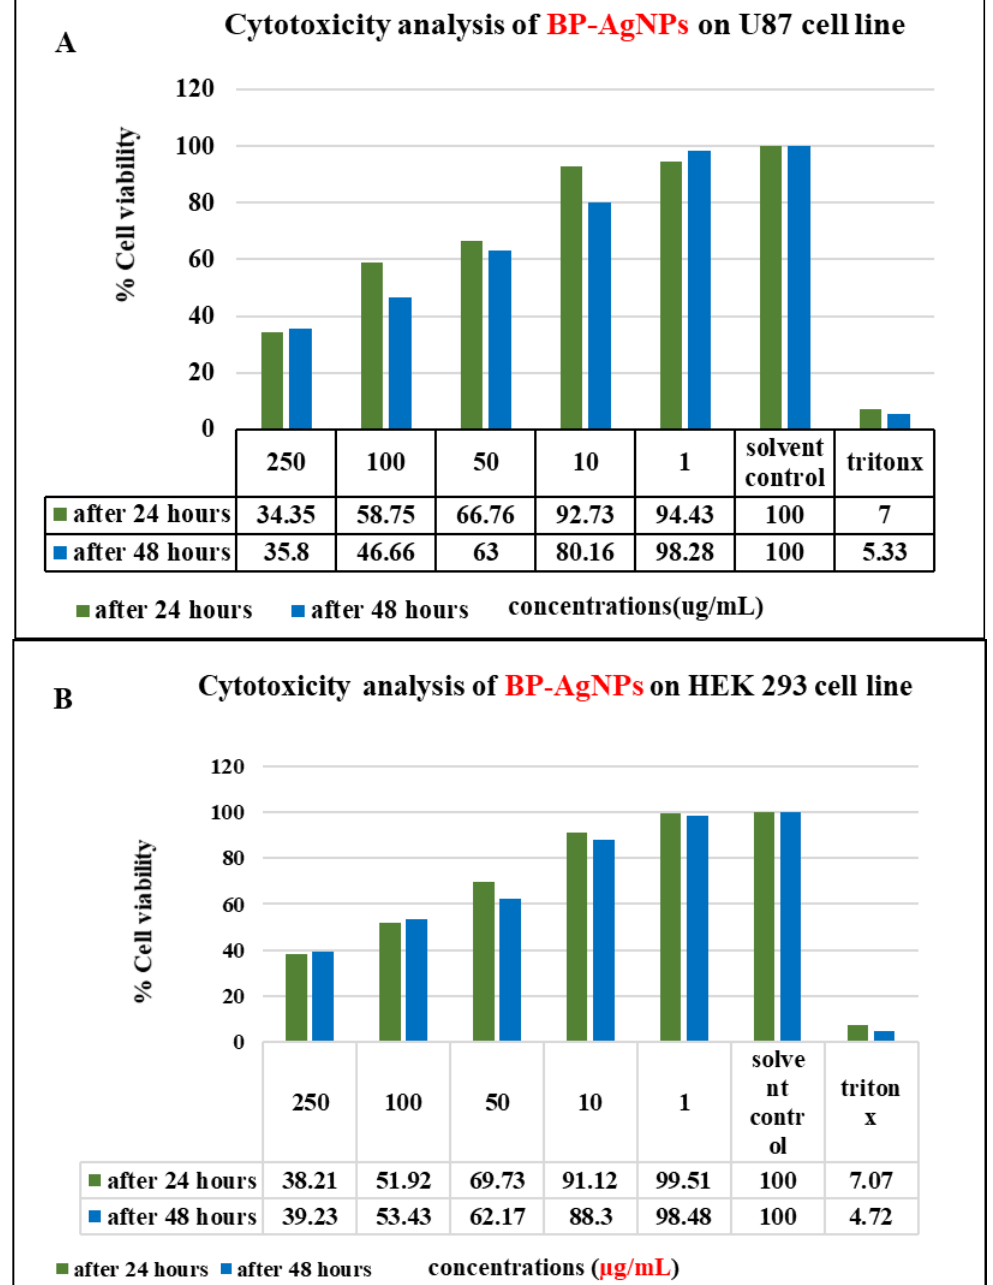
Figure 10. Cytotoxic potency of silver nanoparticles on cancer cell line ( A ) U87 and ( B ) HEK293 after 24 and 48 h of exposure.